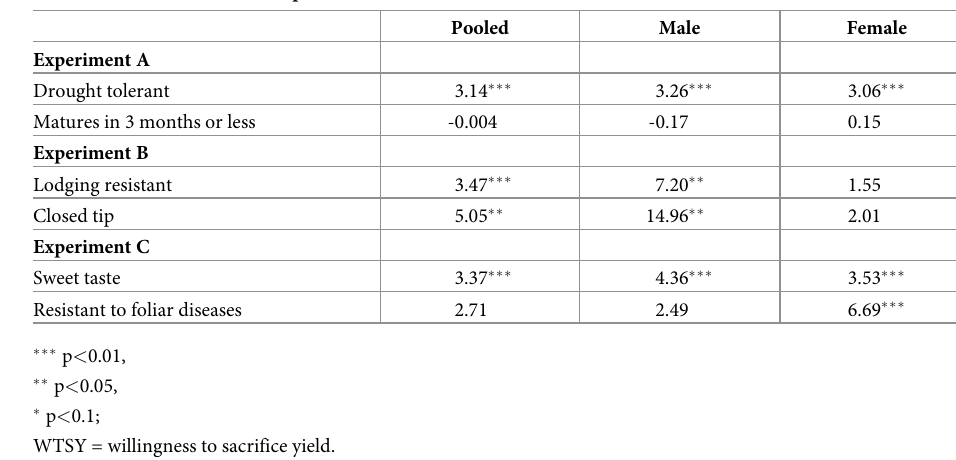
Table 6. Mean WTSY for